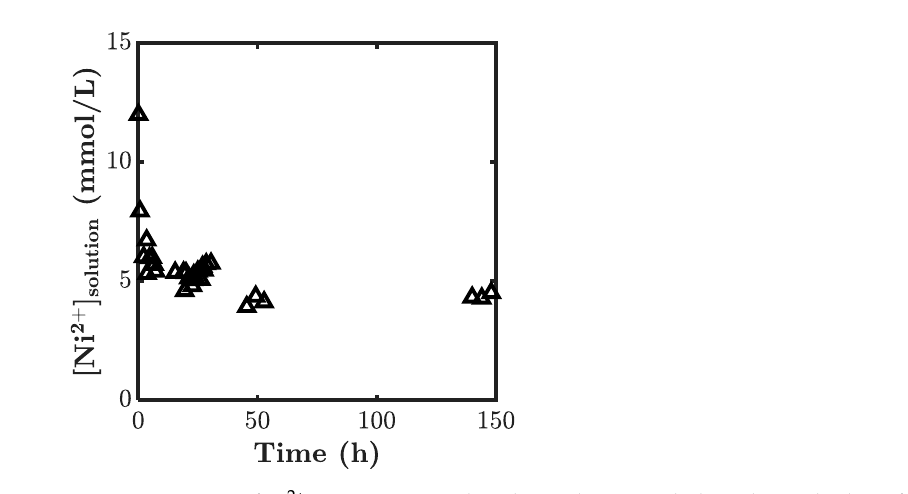
Figure 3. Decrease of Ni 2+ concentration in the solution due to uptake by a chemical gel as a function of time.